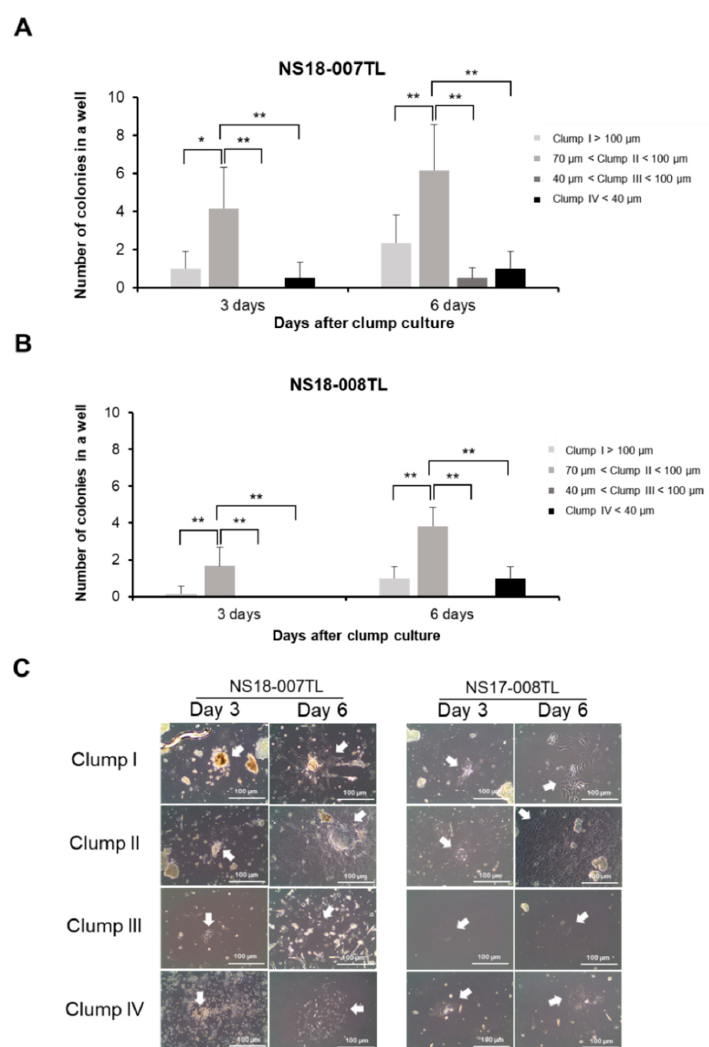
Figure 2. Colony forming efficiency of clumps. Adherent colonies from each clump-type were counted and photographed at 3 days and 6 days after in vitro culture (( A , B ) respectively, n = 5 for each group). The number of adherent colonies from each clump-type was compared to each other (( A ) for NS18-007TL and ( B ) for NS18-008TL). Height = average, error bar = standard deviation. * p < 0.05, ** p < 0.01. ( C ) Morphologies of adherent colonies are illustrated. Colonies are indicated by white arrows. Scale bar = 100 µm.